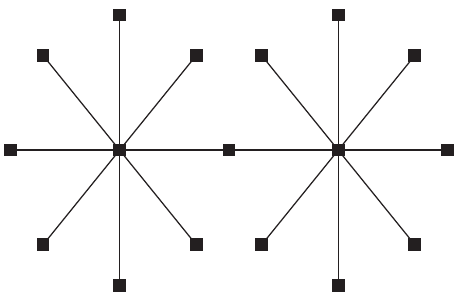
Figure 4. Neutral network-like fitness landscapes. There are two sequences with g ~ 8 neutral neighbors, with l ~ 2 distance between two centers.